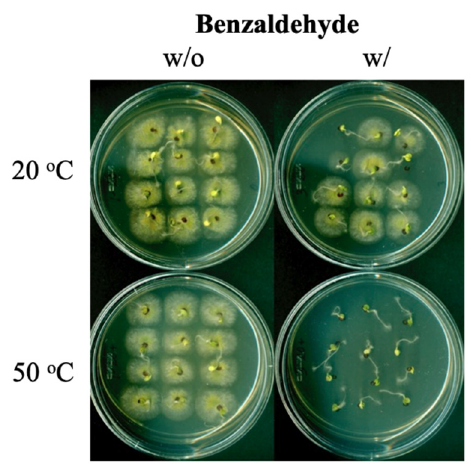
Figure 2. Representative assay showing enhanced seed sanitation via benzaldehyde-mediated heat sensitization (hurdle technology). Co-treatment of benzaldehyde at 3 mM and mild heat (50 °C) for 20 min completely inhibited the growth of A. flavus on the surface of seeds while the frequency of seed germination was unaffected .